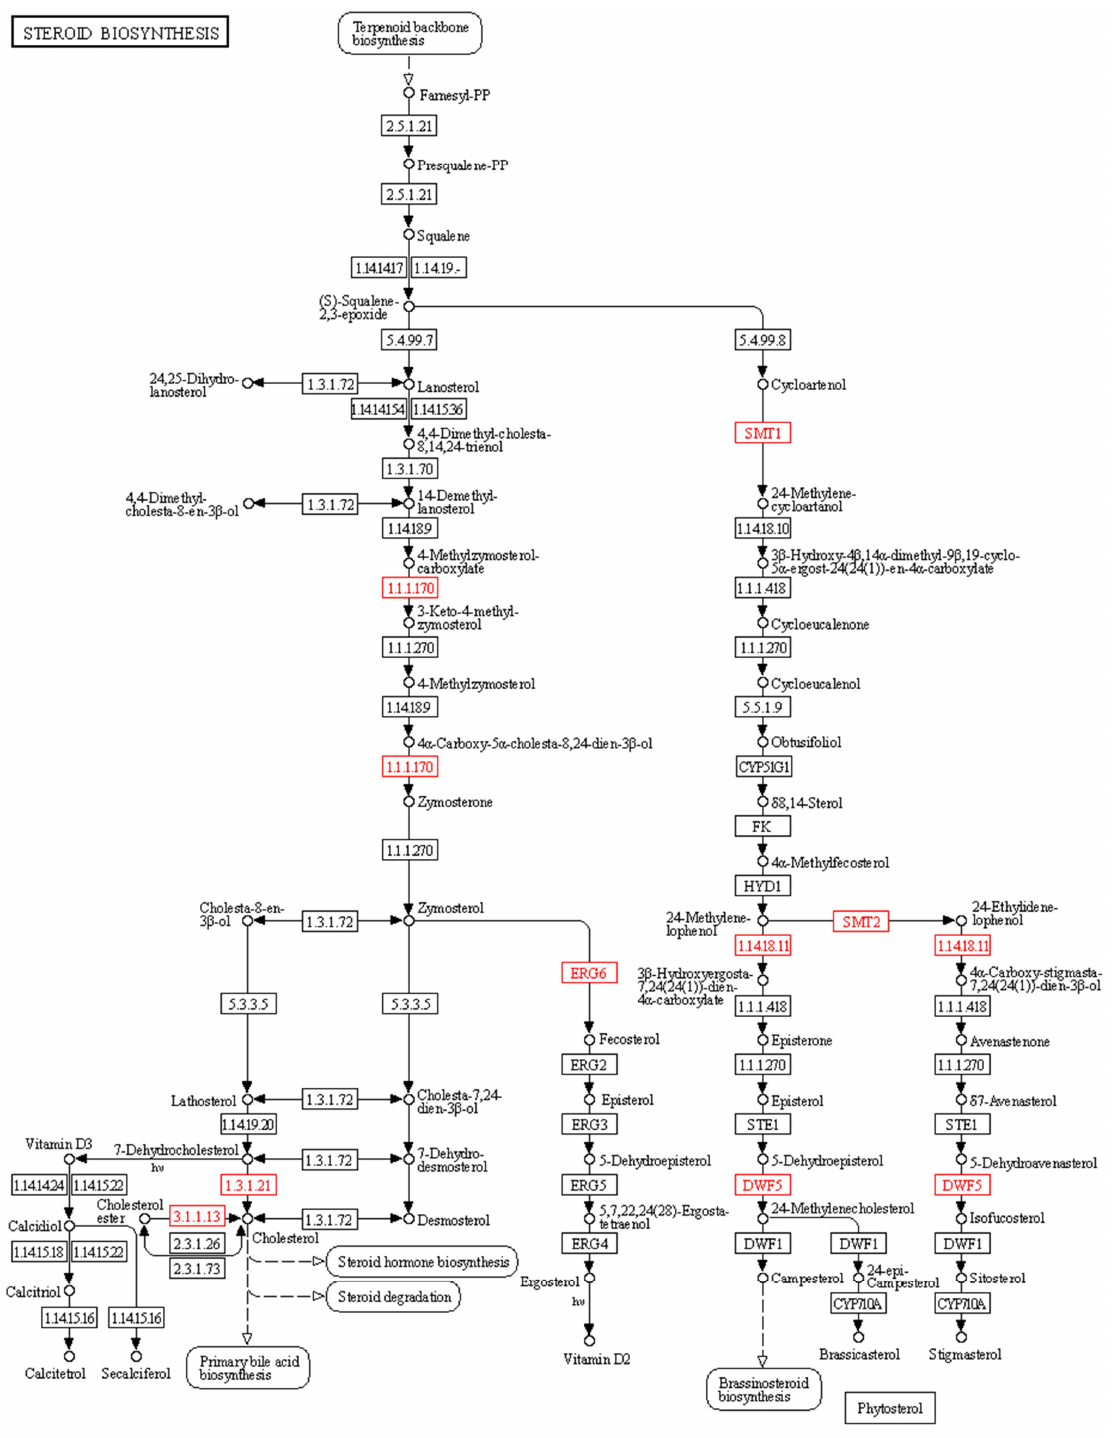
Figure 6. Key enzymes involved in steroid and phytosterol biosynthetic pathways. The identi- F igure 6. Key enzymes involved in steroid and phytosterol biosynthetic pathways . The identified fied DEGs encoding enzymes were highlighted by red colored boxes: (i) sterol-4alpha-carboxylate DEGs encoding enzymes were highlighted by red colored boxes: (i) sterol ‐ 4alpha ‐ carboxylate 3 ‐ 3-dehydrogenase (E1.1.1.170), (ii) 7-dehydrocholesterol reductase (E1.3.1.21), (iii) cholesteryl ester dehydrogenase (E1.1.1.170), (ii) 7 ‐ dehydrocholesterol reductase (E1.3.1.21), (iii) cholesteryl ester hy ‐ hydrolase (E3.1.1.13) and sterol 24-C-methyltransferase (ERG6) (E2.1.1.41), (iv) diphosphomeval- drolase (E3.1.1.13) and sterol 24 ‐ C ‐ methyltransferase (ERG6) (E2.1.1.41), (iv) diphosphomevalonate onate decarboxylase (E4.1.1.33), (v) 24-methylenesterol C-methyltransferase (SMT2) (E2.1.1.143), (vi) 4alpha-monomethylsterol monooxygenase (E1.14.18.11), and (vii) 7-dehydrocholesterol reductase (DWF5)